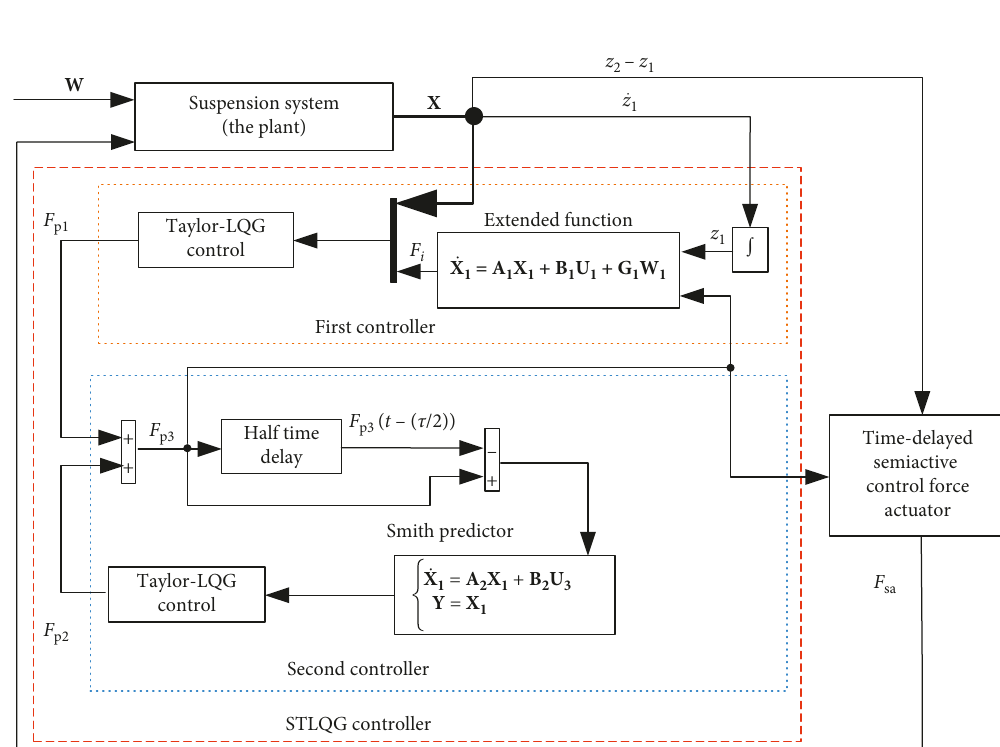
Figure 4: Block diagram of STLQG control system.